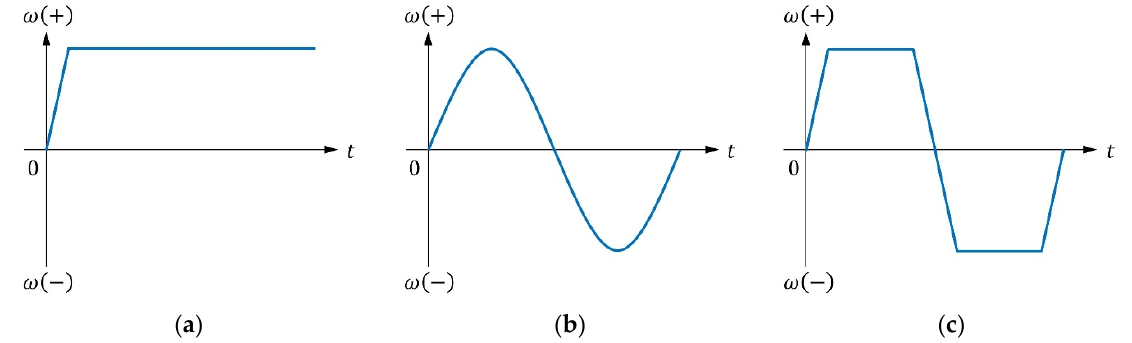
Figure 4. Three motor operating modes: ( a ) unidirectional trapezoidal wave; ( b ) bidirectional sine wave; ( c ) bidirectional trapezoidal wave.